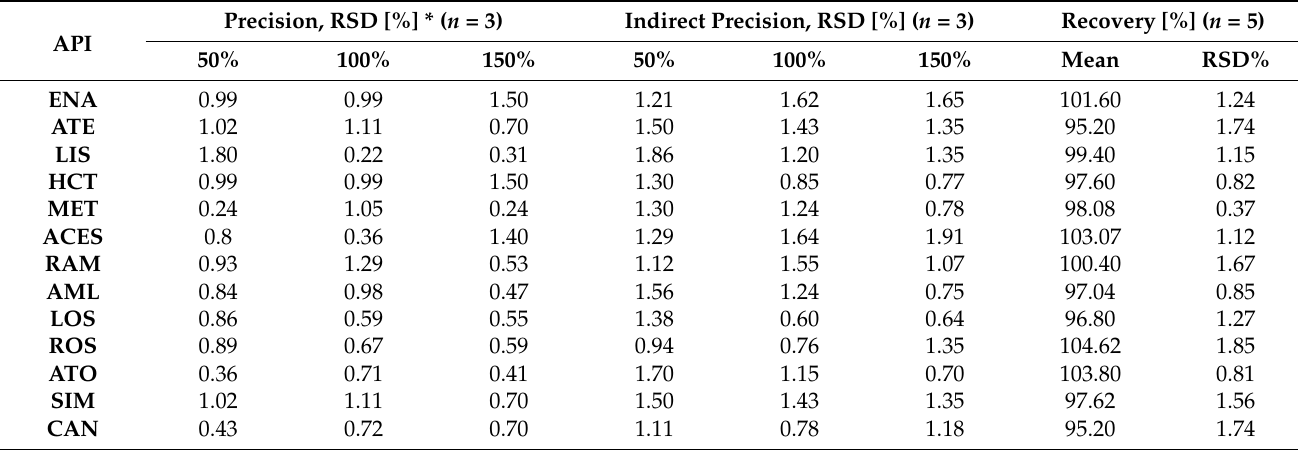
Table 5. Precision and accuracy of the method.